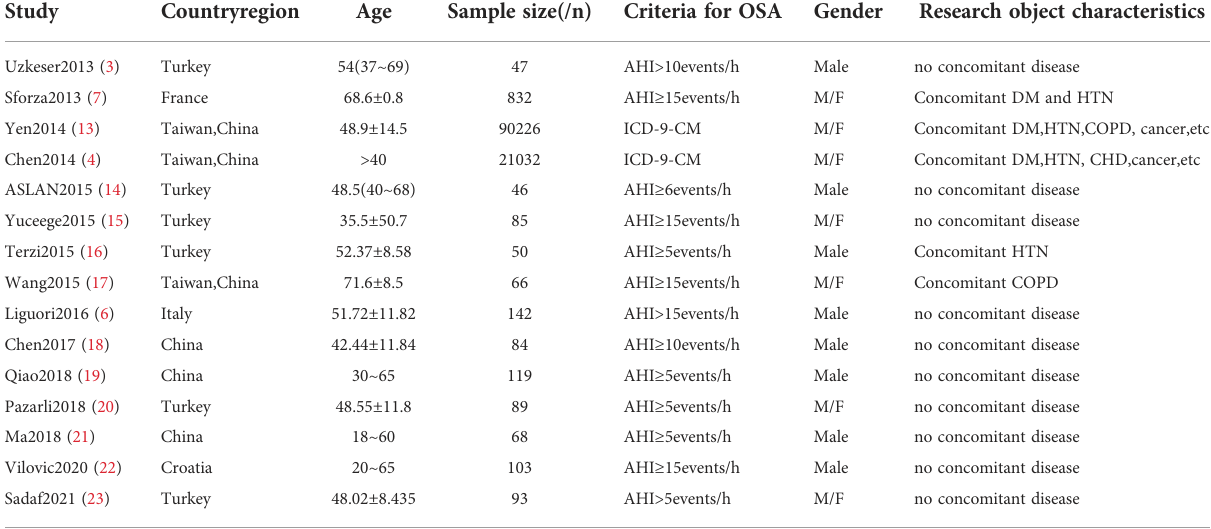
TABLE 1 Basic features of the included